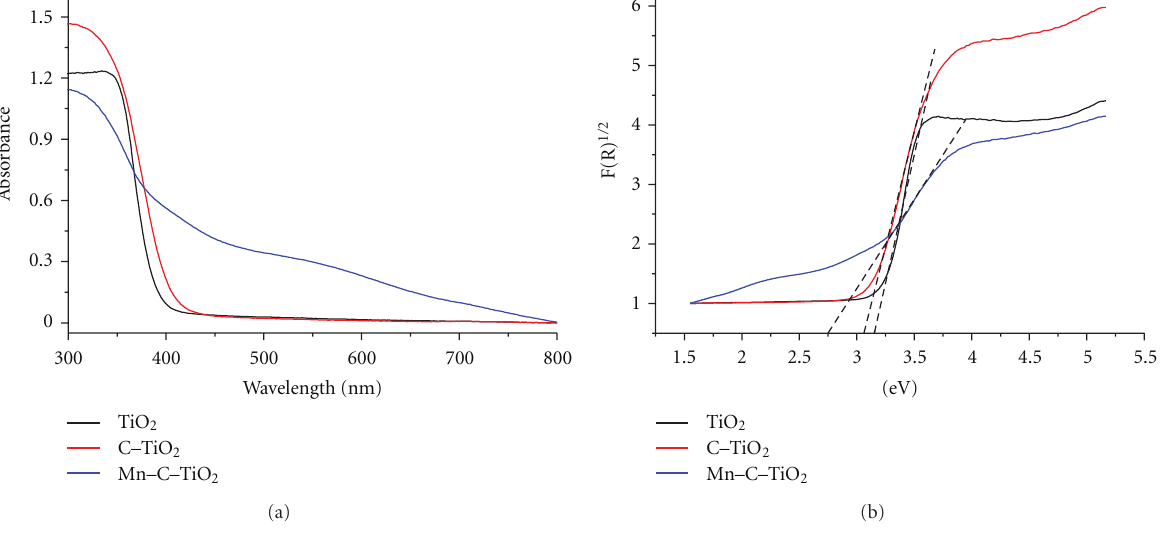
Figure 6: Optical properties of TiO 2 , C–TiO 2 , and Mn–C–TiO 2 .